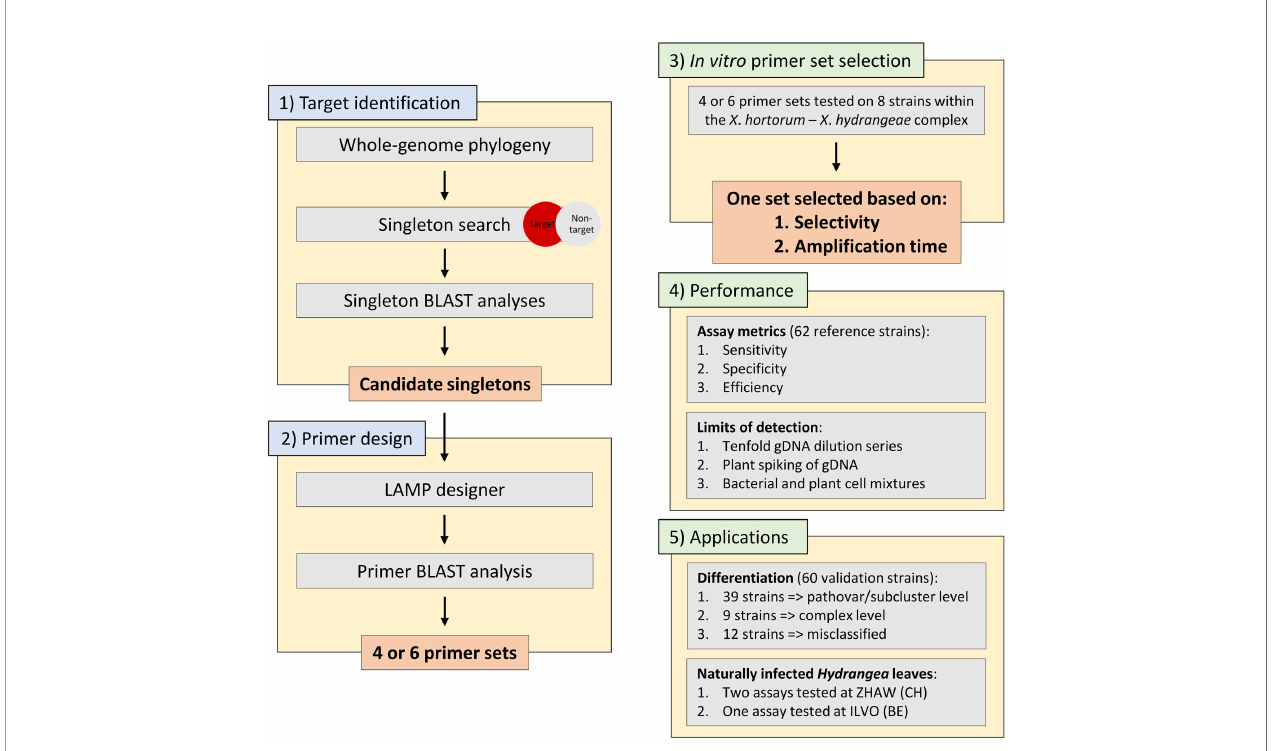
FIGURE 1 | The work fl ow used within this work starting from 1) target identi fi cation using a singleton whole genome phylogeny approach, 2) subsequent LAMP primer design, 3) an in vitro primer set selection based on eight representative strains within the Xanthomonas hortorum – Xanthomonas hydrangeae species complex, 4) performance testing of the seven assays on 62 reference strains including assays metrics (e.g., sensitivity, speci fi city, and ef fi ciency) and limits of detection (e.g., tenfold genomic DNA dilution series and spiking of genomic DNA with plant material) and, 5) the two main applications of the seven assays. gDNA, genomic